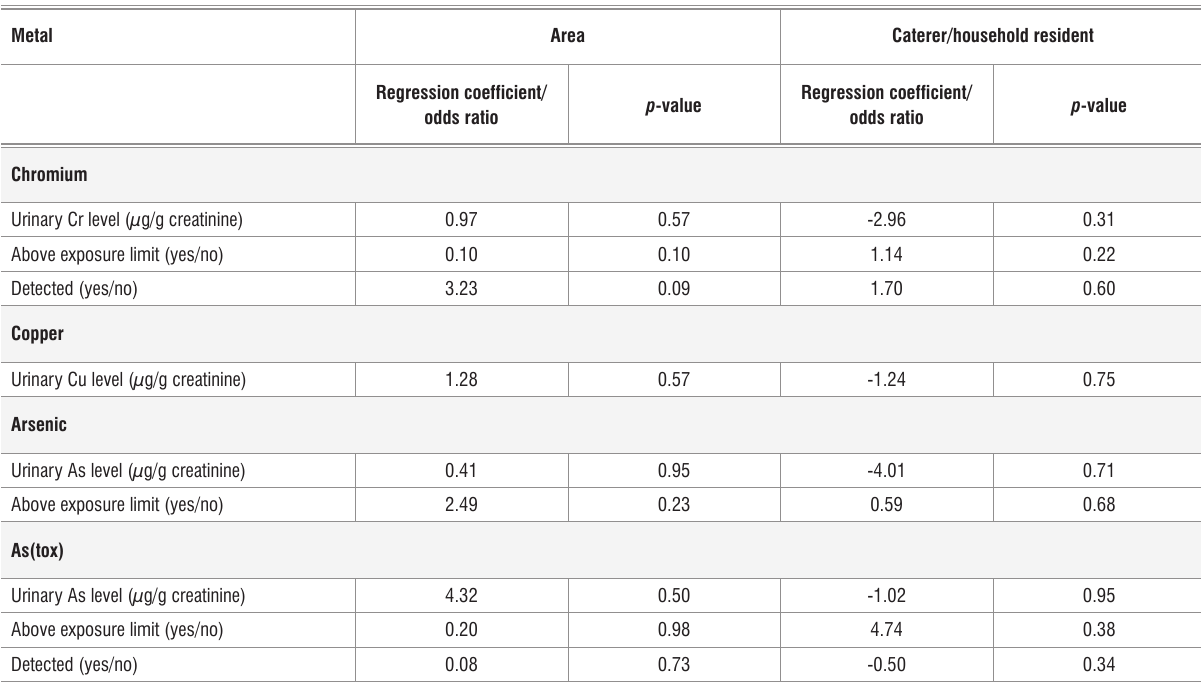
Table 5: Multivariate (linear and logistic regression analyses) relationships between urinary levels of chromium, copper and arsenic as the outcome (dependent) variables, and area and caterer/resident as the exposure variables in separate